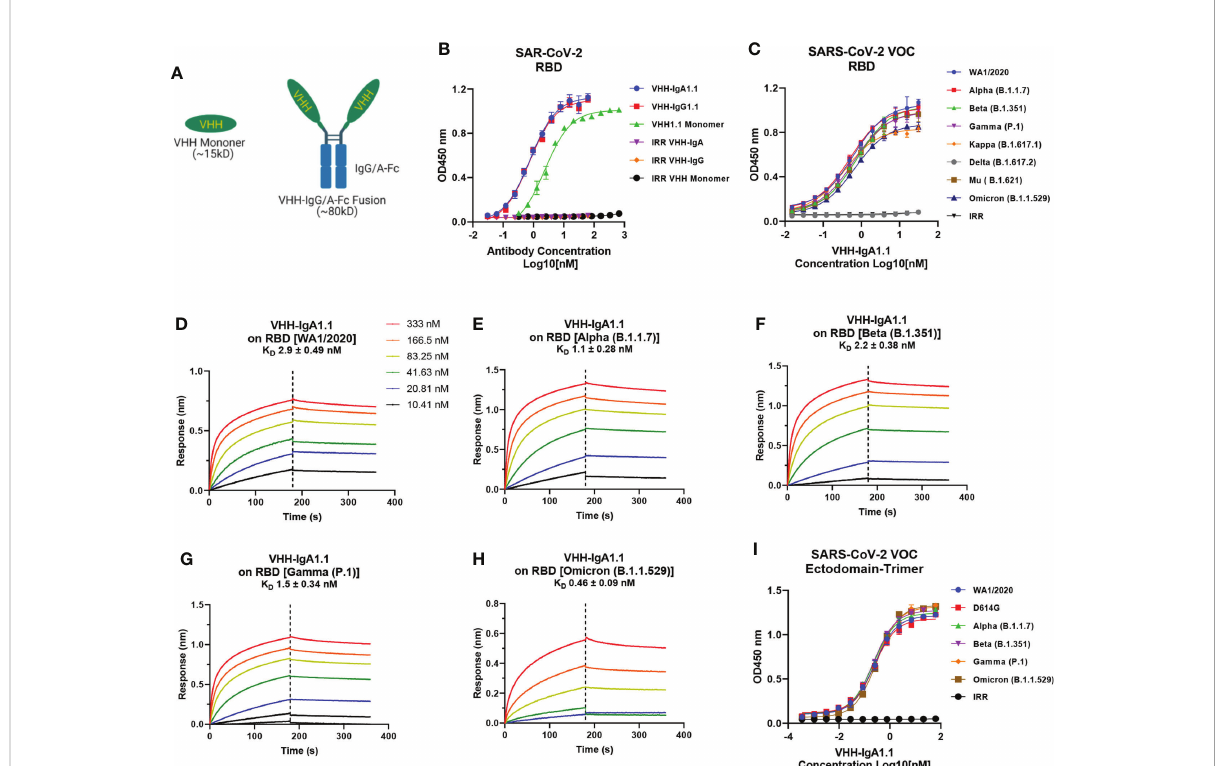
FIGURE 1 Binding of VHH-IgA1.1 to spike proteins of SARS-CoV-2 and VOC. (A) Illustration of VHH engineering from monomer into IgG or IgA-Fc fusions. (B) Comparison of VHH1.1 monomer, VHH-IgG1.1 and VHH-IgA1.1 binding with SARS-CoV-2 RBD domain in ELISA. (C) ELISA binding of VHH- IgA1.1 with RBD and soluble ectodomain trimer (I) generated from indicated SARS-CoV-2 VOC strains. (D – H) Af fi nity measurements of VHH- IgA1.1 against RBD of SARS-CoV-2 VOC were conducted using bio-layer interferometry. Data is plotted as the average ± SD from at least 3 independent